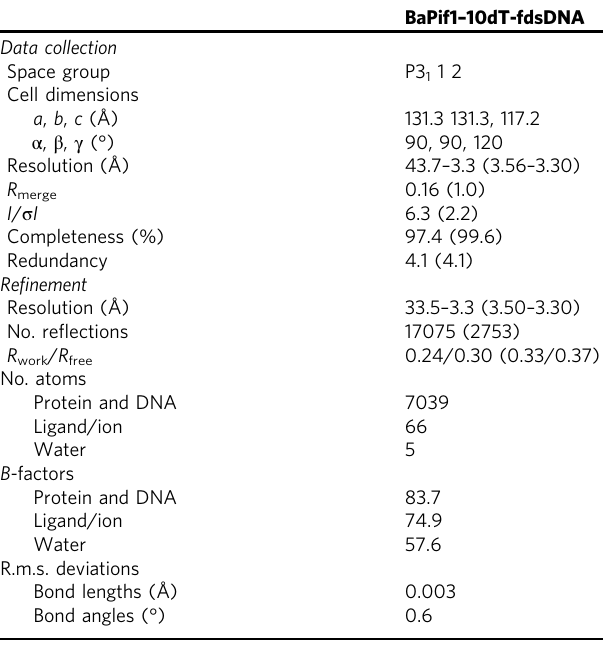
Fig. 7 Mechanism of unwinding forked dsDNA by BaPif1 helicases. Two molecules of BaPif1 bind to a replication fork; one (orange) binds to the 5 ′ arm of the fork on the lagging strand template. This BaPif1 bends the ssDNA, which melts the fi rst base pair of the duplex. The other (green) binds to the 3 ʹ arm of the fork on the leading strand template and stabilizes the ss/ds junction. Interactions between the two BaPif1 molecules occur at the junction and appear to limit the processivity of the individual BaPif1 molecules. Upon ATP hydrolysis, each BaPif1 molecule can unwind DNA in a 5 ʹ to 3 ʹ direction. When the interactions in the dimer interface for the E323 variants are reduced, the BaPif1dimer may separate and each molecule may unwind DNA independently.